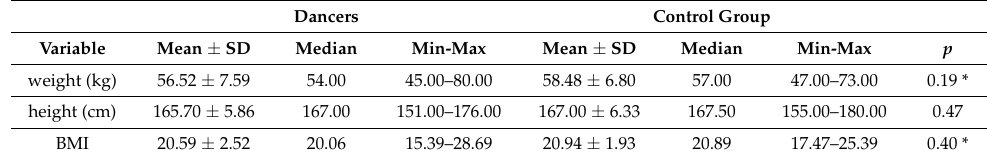
Table 1. Demographic data of